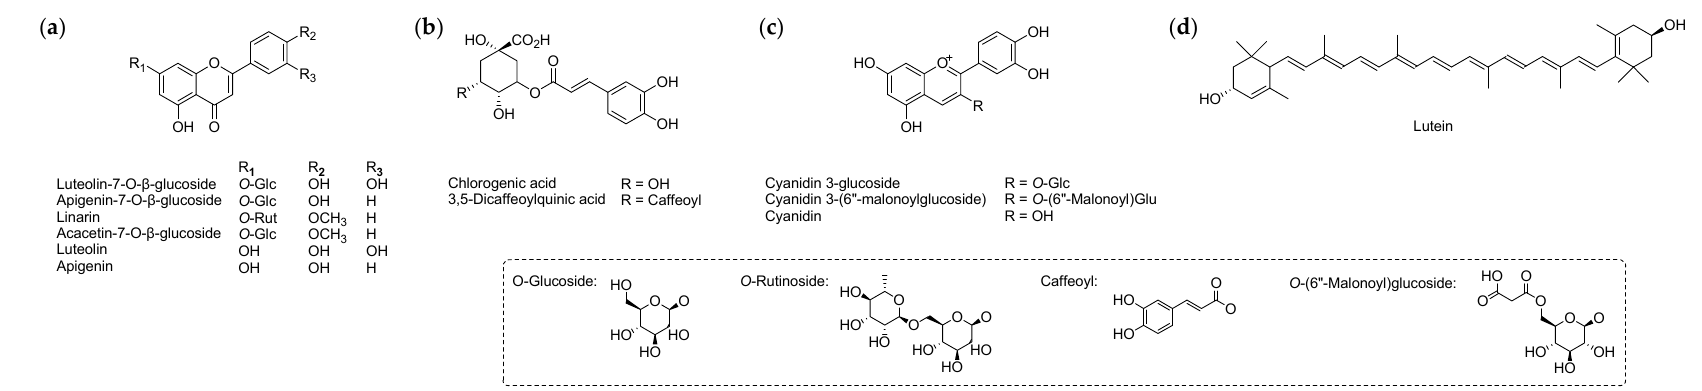
Figure 2. Structures of the standard materials. ( a ) Flavonoids; ( b ) phenolic acids; ( c ) anthocyanins; ( d ) carotenoids. Table 1. The contents of flavonoid and phenolic acid in the chrysanthemum cultivars.